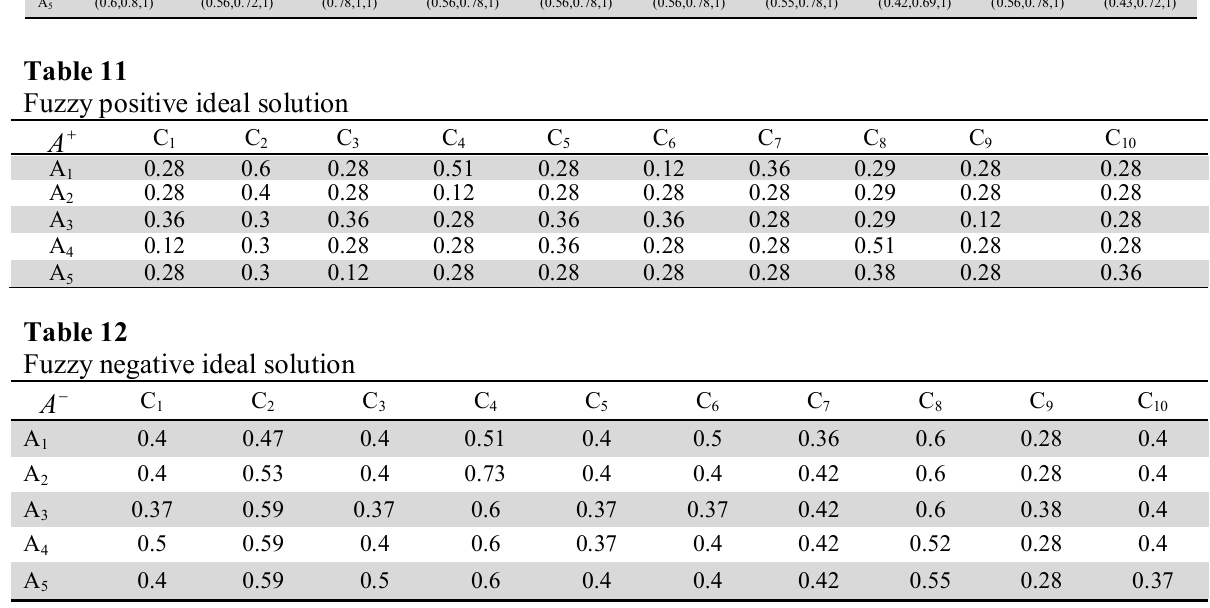
Closeness coefficient (CC